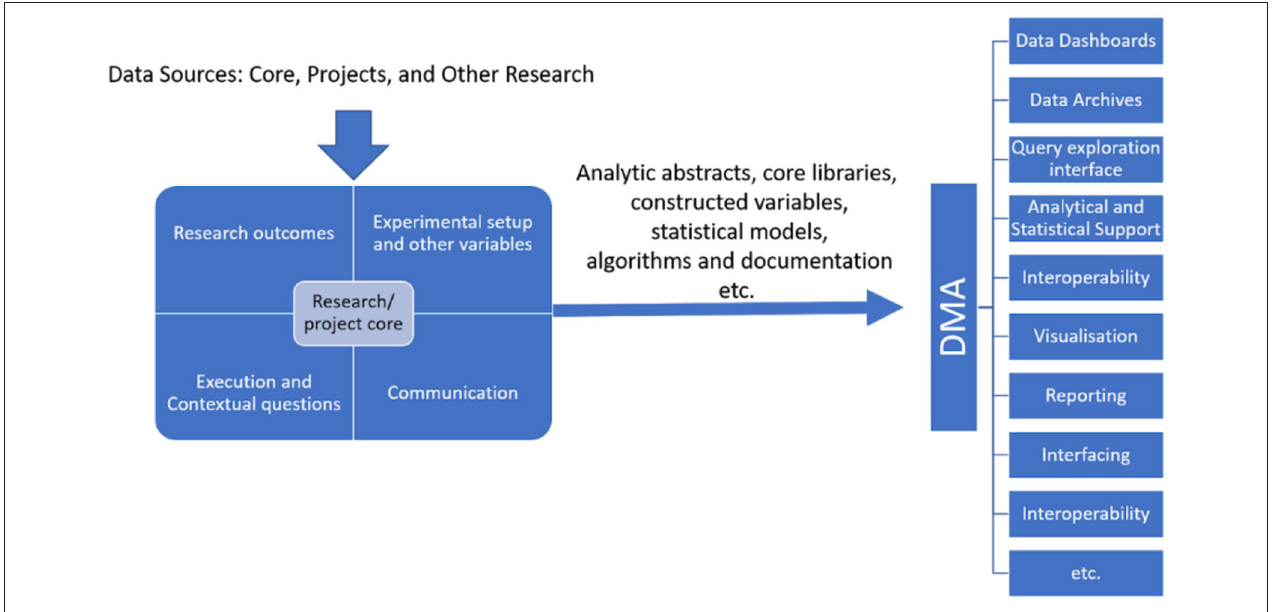
FIGURE 4 | Dataflow across stakeholders in UAE and